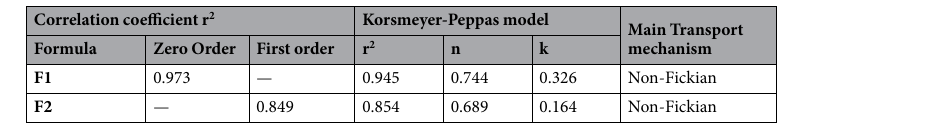
Table 3. The kinetic release profiles of the gel systems for AuNPs.